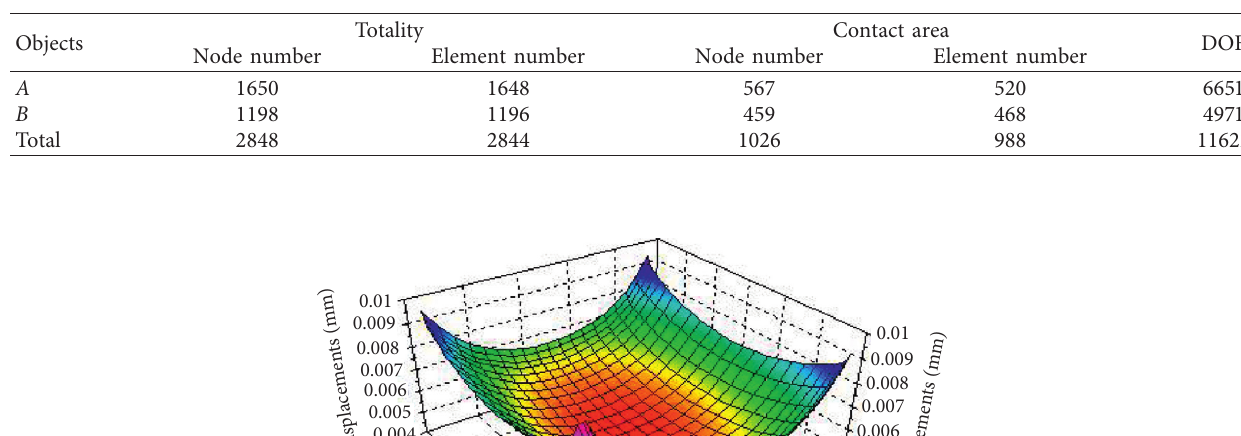
Figure 3: Computation model and discrete mesh. Table 1: Discrete data.